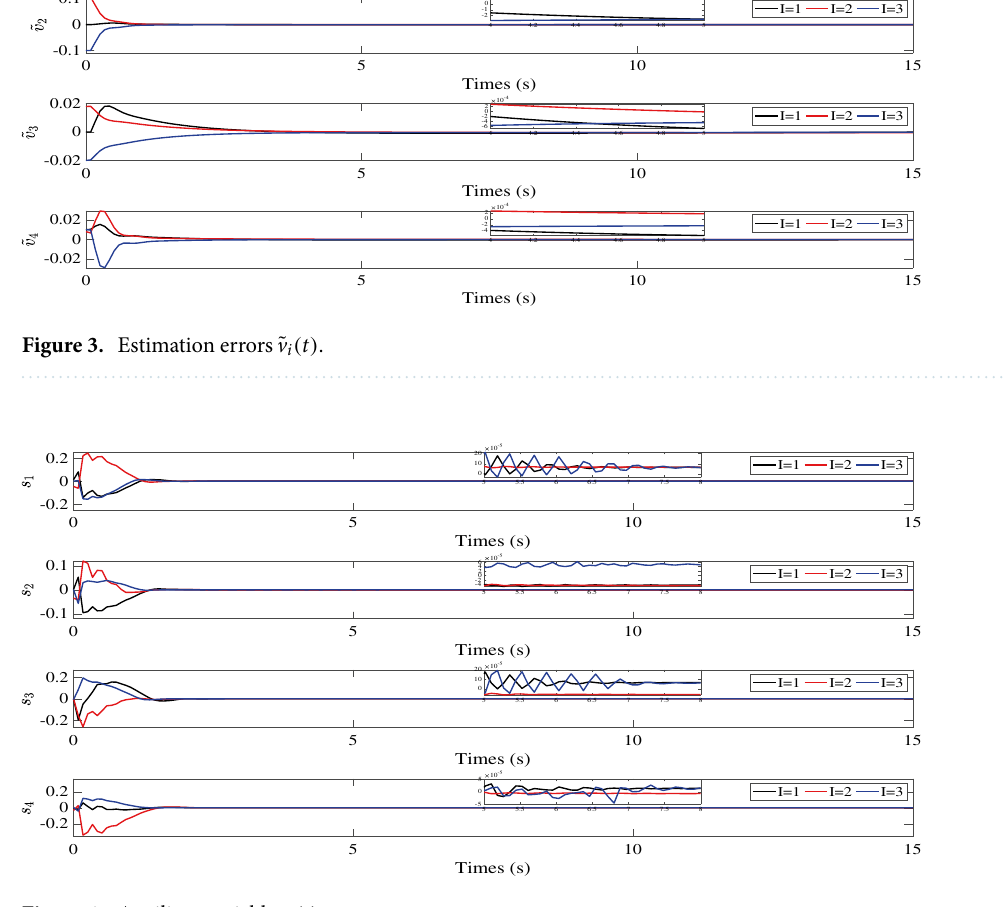
Figure 4. Auxiliary variable s i ( t )